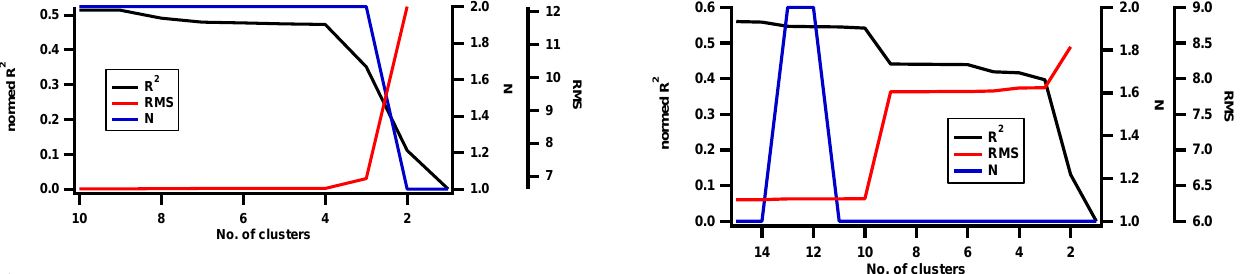
Fig. 6. Ambient WIBS3 data set clustering statistics. Four-cluster solution chosen due concomitant drop in R 2 and rise in RMS. Table 4. Cluster averages and relative standard deviations for the WIBS3 data set. Bottom row shows the number of constituent mea- surements.